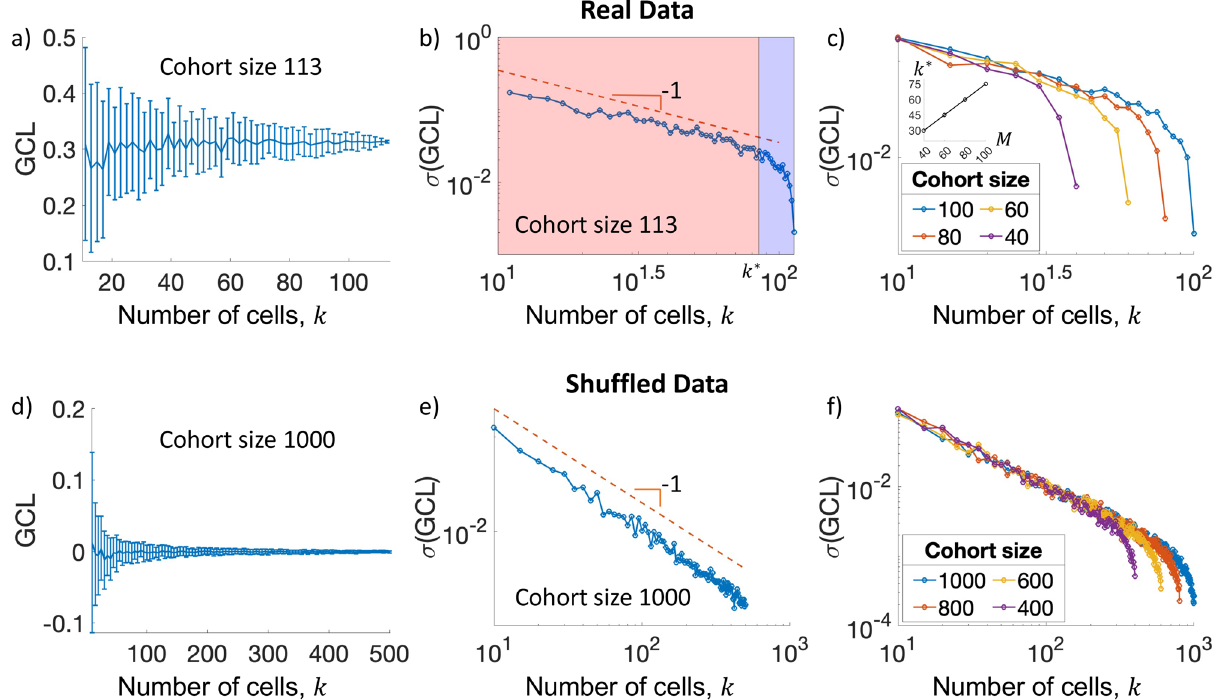
113 cells (as Figure 4. The effect of jackknife sample size on the GCL variability. Given a cohort of M = 40 subsets with k < M cells and calculate the GCL of each detailed in the text), we re-sample at random s = subset. ( a ) Mean and standard deviation, σ( GCL ) , of the GCL distributions as a function of k , represented by the center and the length of the error bars, respectively. ( b ) The standard deviation, σ( GCL ) , as a function of k . The red area, where k < k ∗ is dominated by the finite-size effects. When k > k ∗ , the σ( GCL ) drops much more rapidly, due to the large overlap between the jackknife subsets. ( c ) The same analysis as in ( b ) but for four 40, 60, 80, 100 , where each cohort is chosen at random from the total 113 real data cohorts of sample-size M = cells. The inset shows k ∗ versus the cohort size, M . The linear relationship suggests that an optimal k value is approximately 75% of the sample-size. ( d – f ) Similar analyses as in ( a – c ) but for shuffled data with a cohort size 75% 1000 . In this case, the average GCL is 0. The optimal value of k 20 M still holds. We use m of M ≈ × = = for all GCL